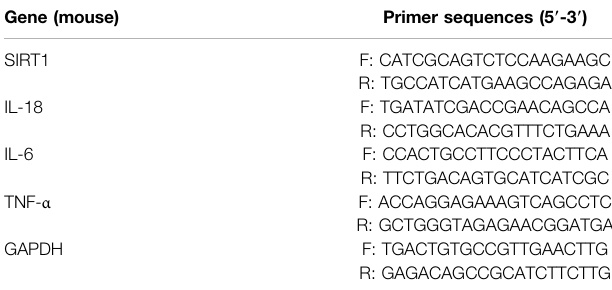
TABLE 1 | The primers of genes Gene (mouse) Primer sequences (5 9 -3 9 )